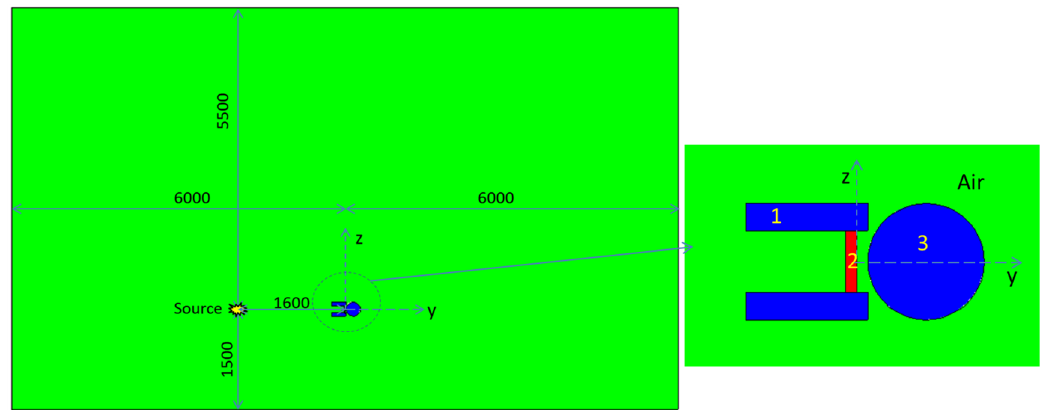
Figure 7. Neutron transmission simulation model. 1: Polyethylene shielding layer; 2: material sample (BCC Model for DM and Uniform Filling Model for BSS); 3: neutron ambient dose equivalent (rate) meters; 4: the green color indicates the surrounding air. The dimension of the x-axis is consistent with that of the y-axis, that is 6000 mm.